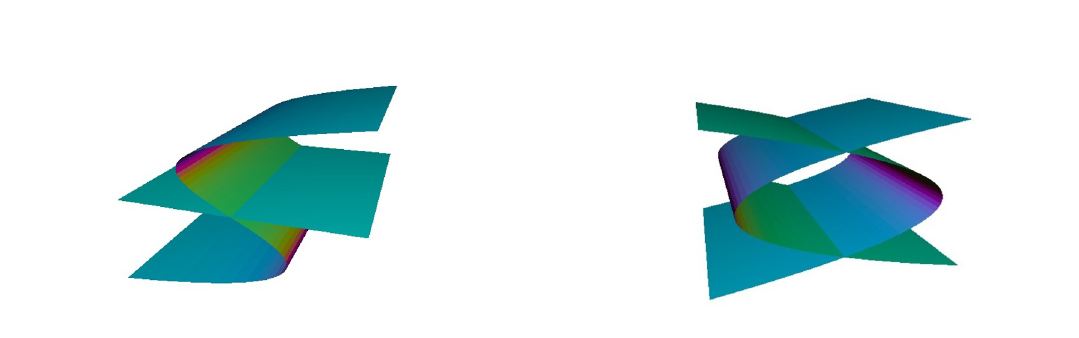
Figure 7 . Reducible degree four spectral covers with reduced